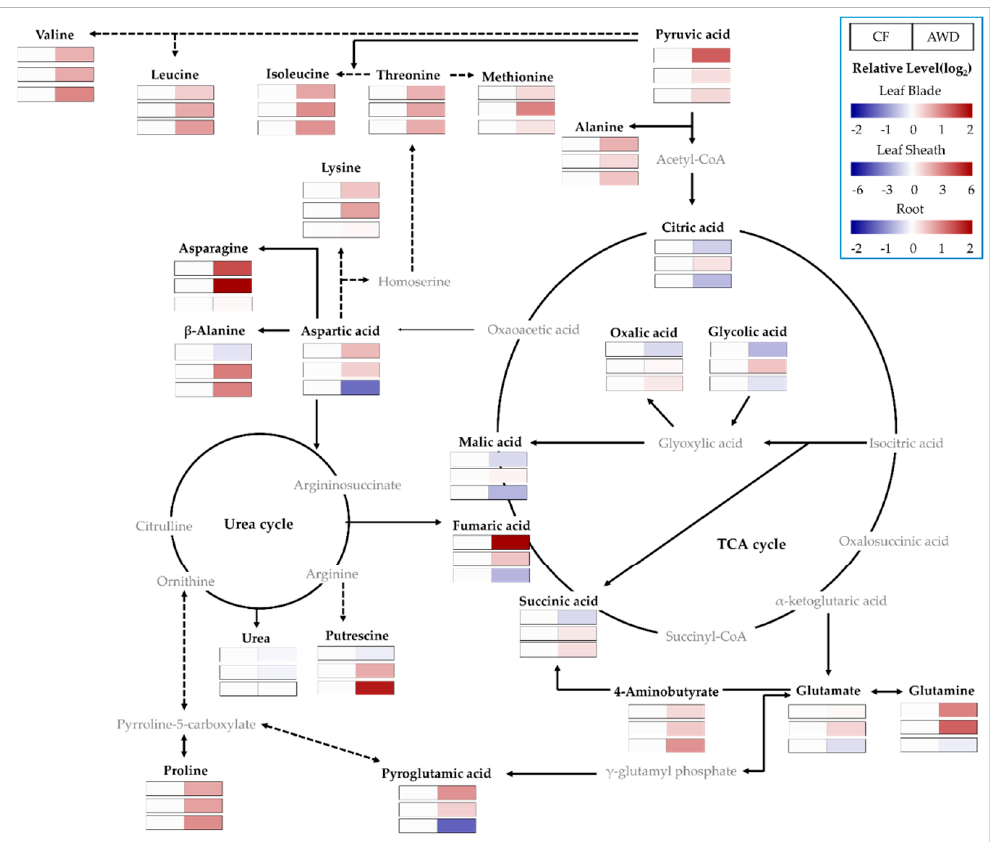
Figure 3. Primary metabolic changes (relative level of AWD to CF) in leaf blade, leaf sheath, and root at heading stage subjected to different water managements; CF, continuous flooding; AWD, alternative we tt ing and drying (n = 3).